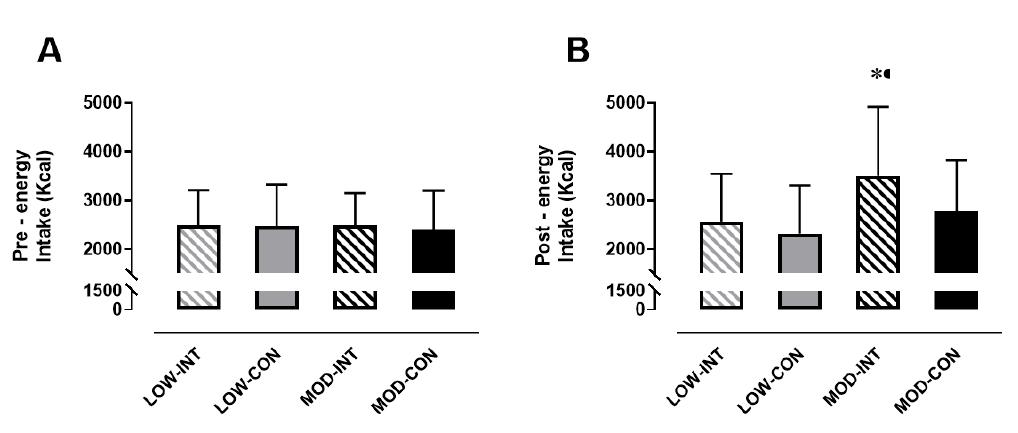
Figure 5. ( A ) Pre-trial energy intake (kCal) ( n = 12), and ( B ) post-trial energy intake over 24 h (kCal) ( n = 11). Data points are means with vertical error bars representing SDs. * Indicates MOD-INT is significantly di ff erent than MOD-CON, determined by Bonferroni adjusted paired t -test ( p < 0.05). No main e ff ect of the intensity × modality ( p = 0.093, η 2 p = 0.256) interaction was detected for 24 h post trial energy intake (kCal), however a main e ff ect of intensity ( p = 0.005, η 2 p = 0.556) and modality ( p = 0.001, η 2 p = 0.667) was observed. Post-hoc tests revealed MOD-INT was significantly higher compared to MOD-CON (3500 ± 1419